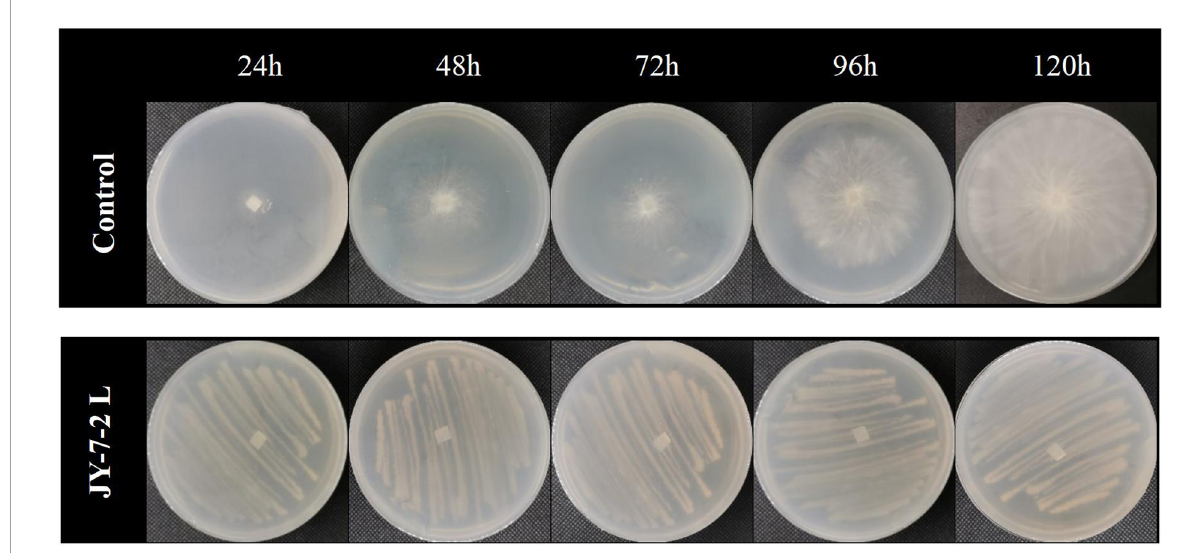
FIGURE5 Effect of volatile compounds produced by JY-7-2L on hyphal growth of Sclerotium